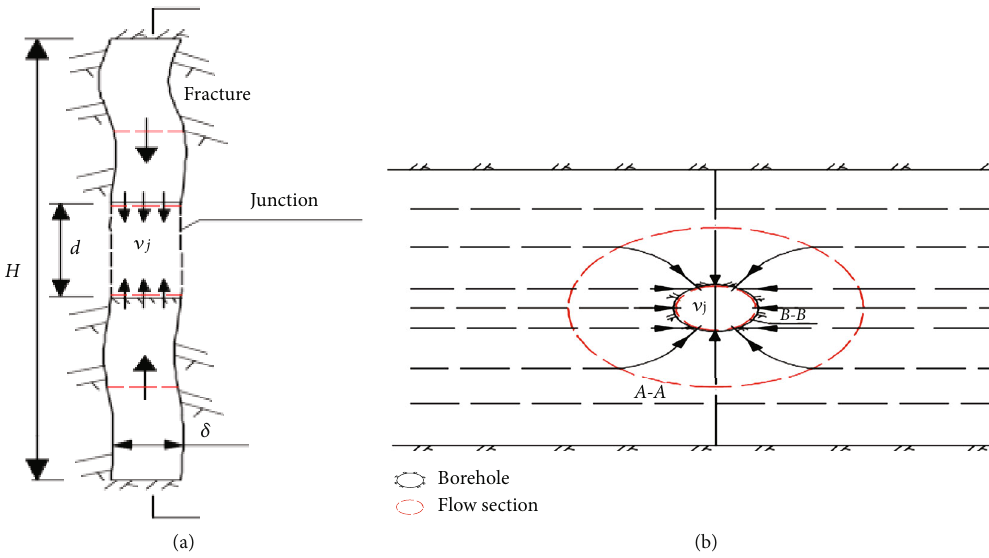
Figure 7: Flow at the junction from a narrow fracture penetrated by a